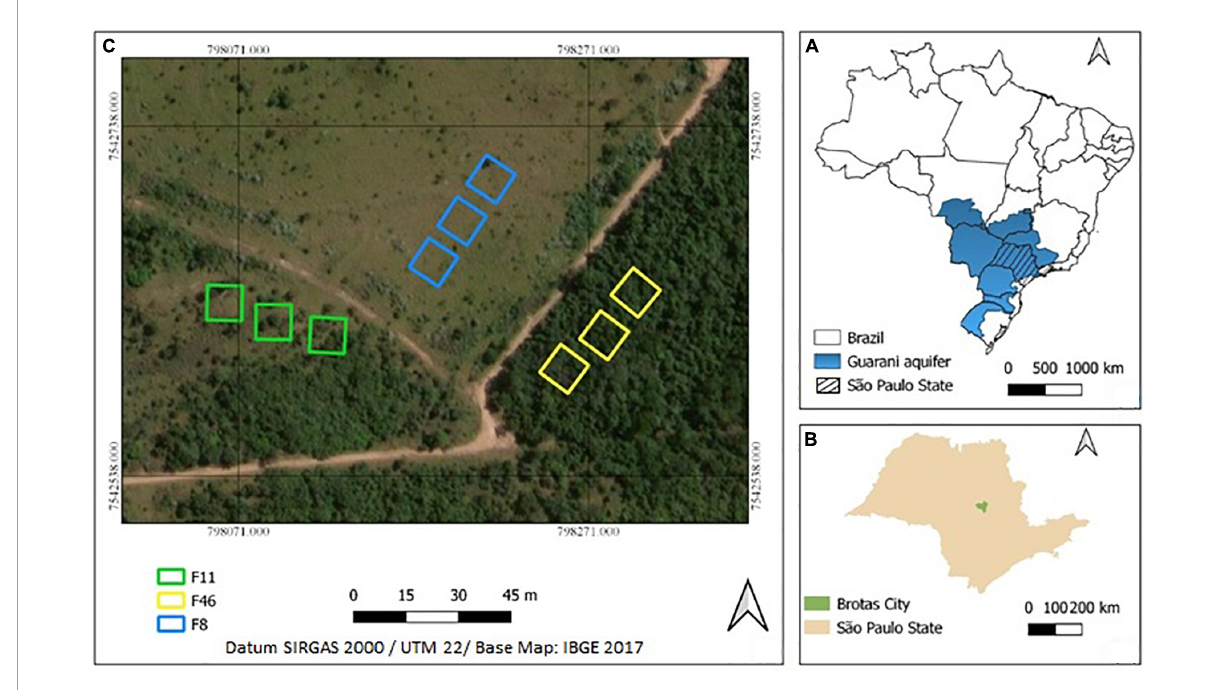
FIGURE1 Guarani aquifer extension in Brazil (A) , Brotas location in São Paulo state (B) and, study area location (F8, F11, and F46) in Private Natural Heritage Reserve (RPPN), Águas Perenes Forest (C)